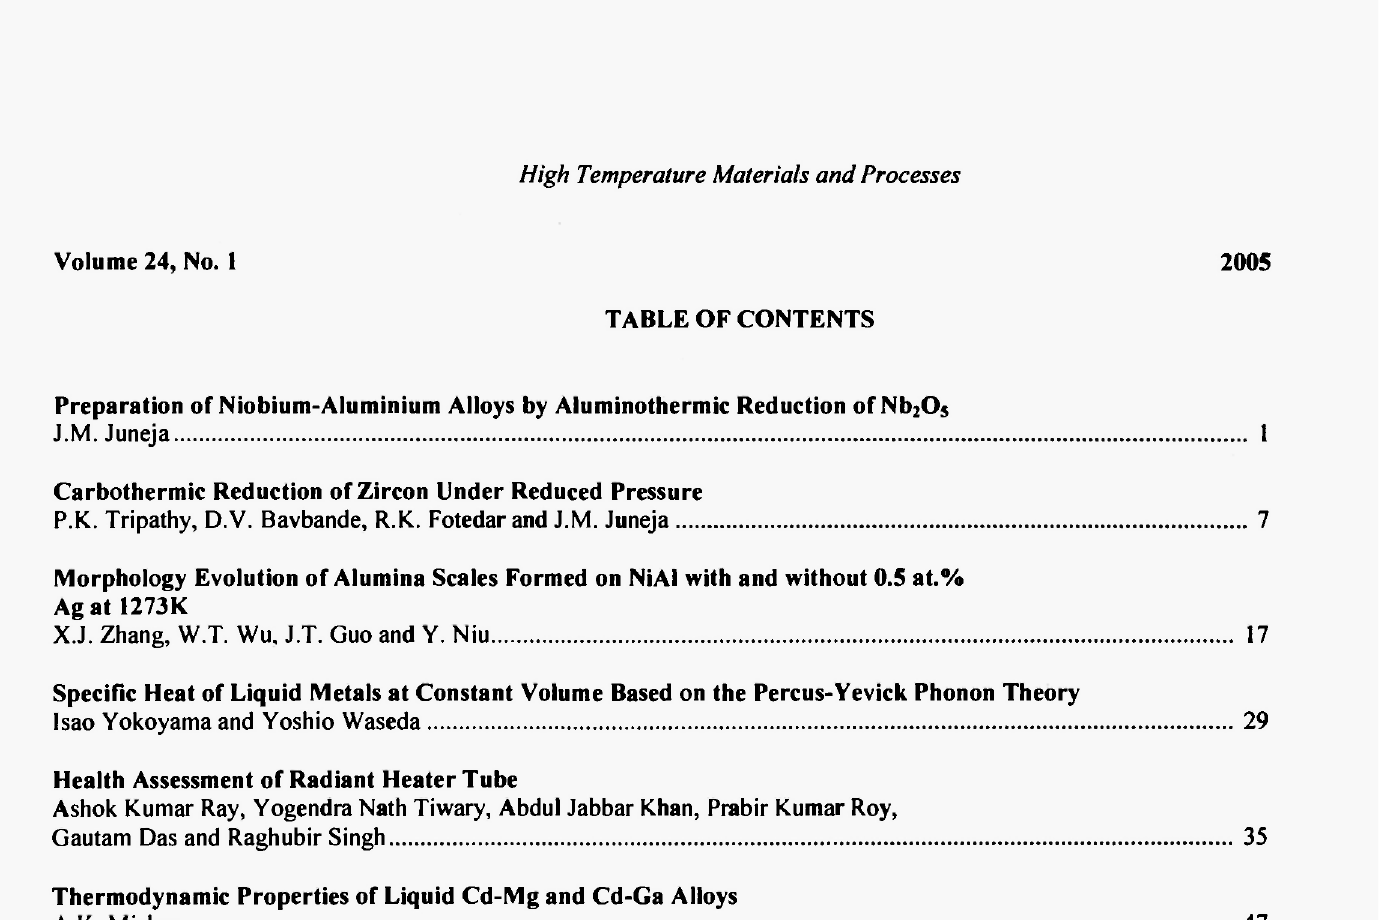
Morphology Evolution of Alumina Scales Formed on NiAl with and without 0.5 at.% Ag at